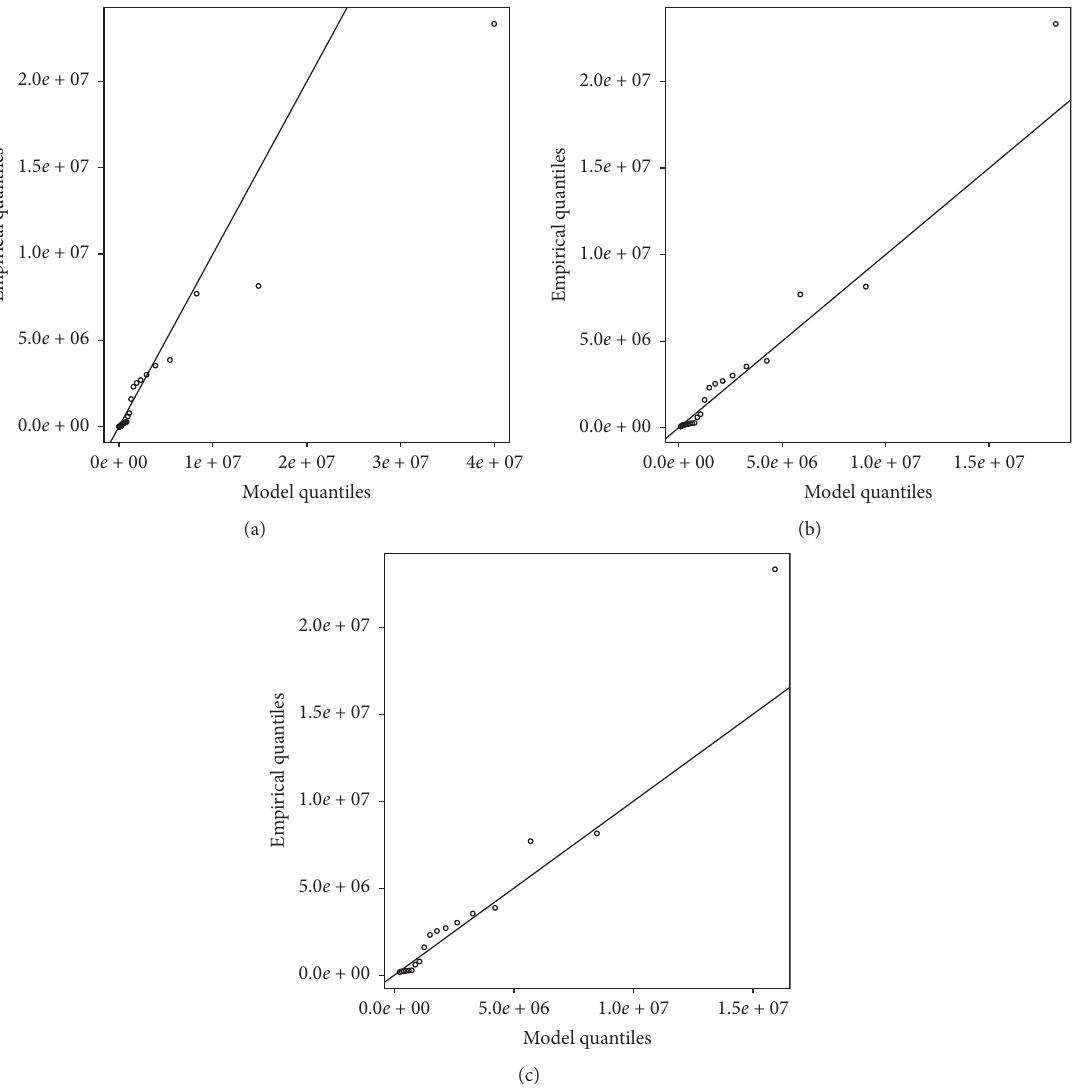
Figure 4: Q-Q plot of GPD at different thresholds. (a) Threshold � 0. (b) Threshold � 50,000. (c) Threshold �